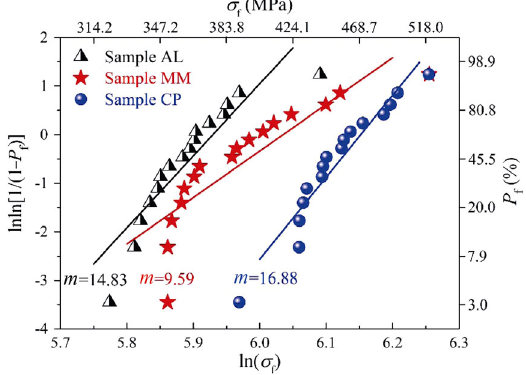
Fig. 12 Weibull plots for the flexural strength of Samples AL, MM, and